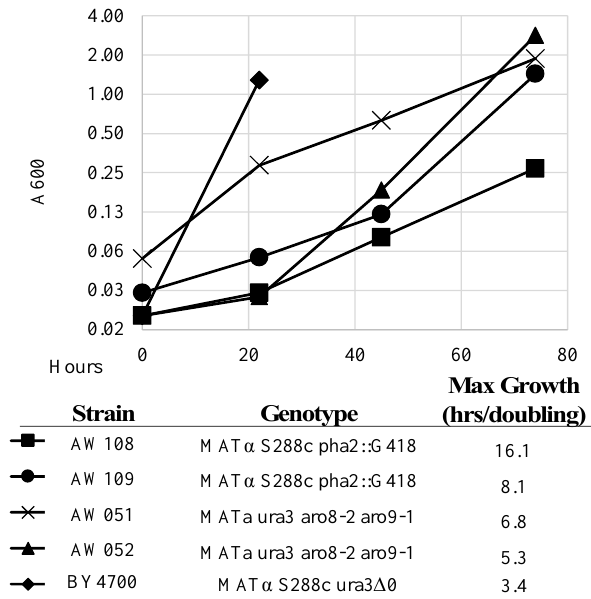
Figure 4. Growth rate of strains in medium lacking phenylalanine. The indicated strains were grown overnight in synthetic complete medium then washed and inoculated to minimal medium with uracil and rotated at 23 °C. The A600 was measured over subsequent hours. Max growth was the lowest growth rate calculated for all points tested.